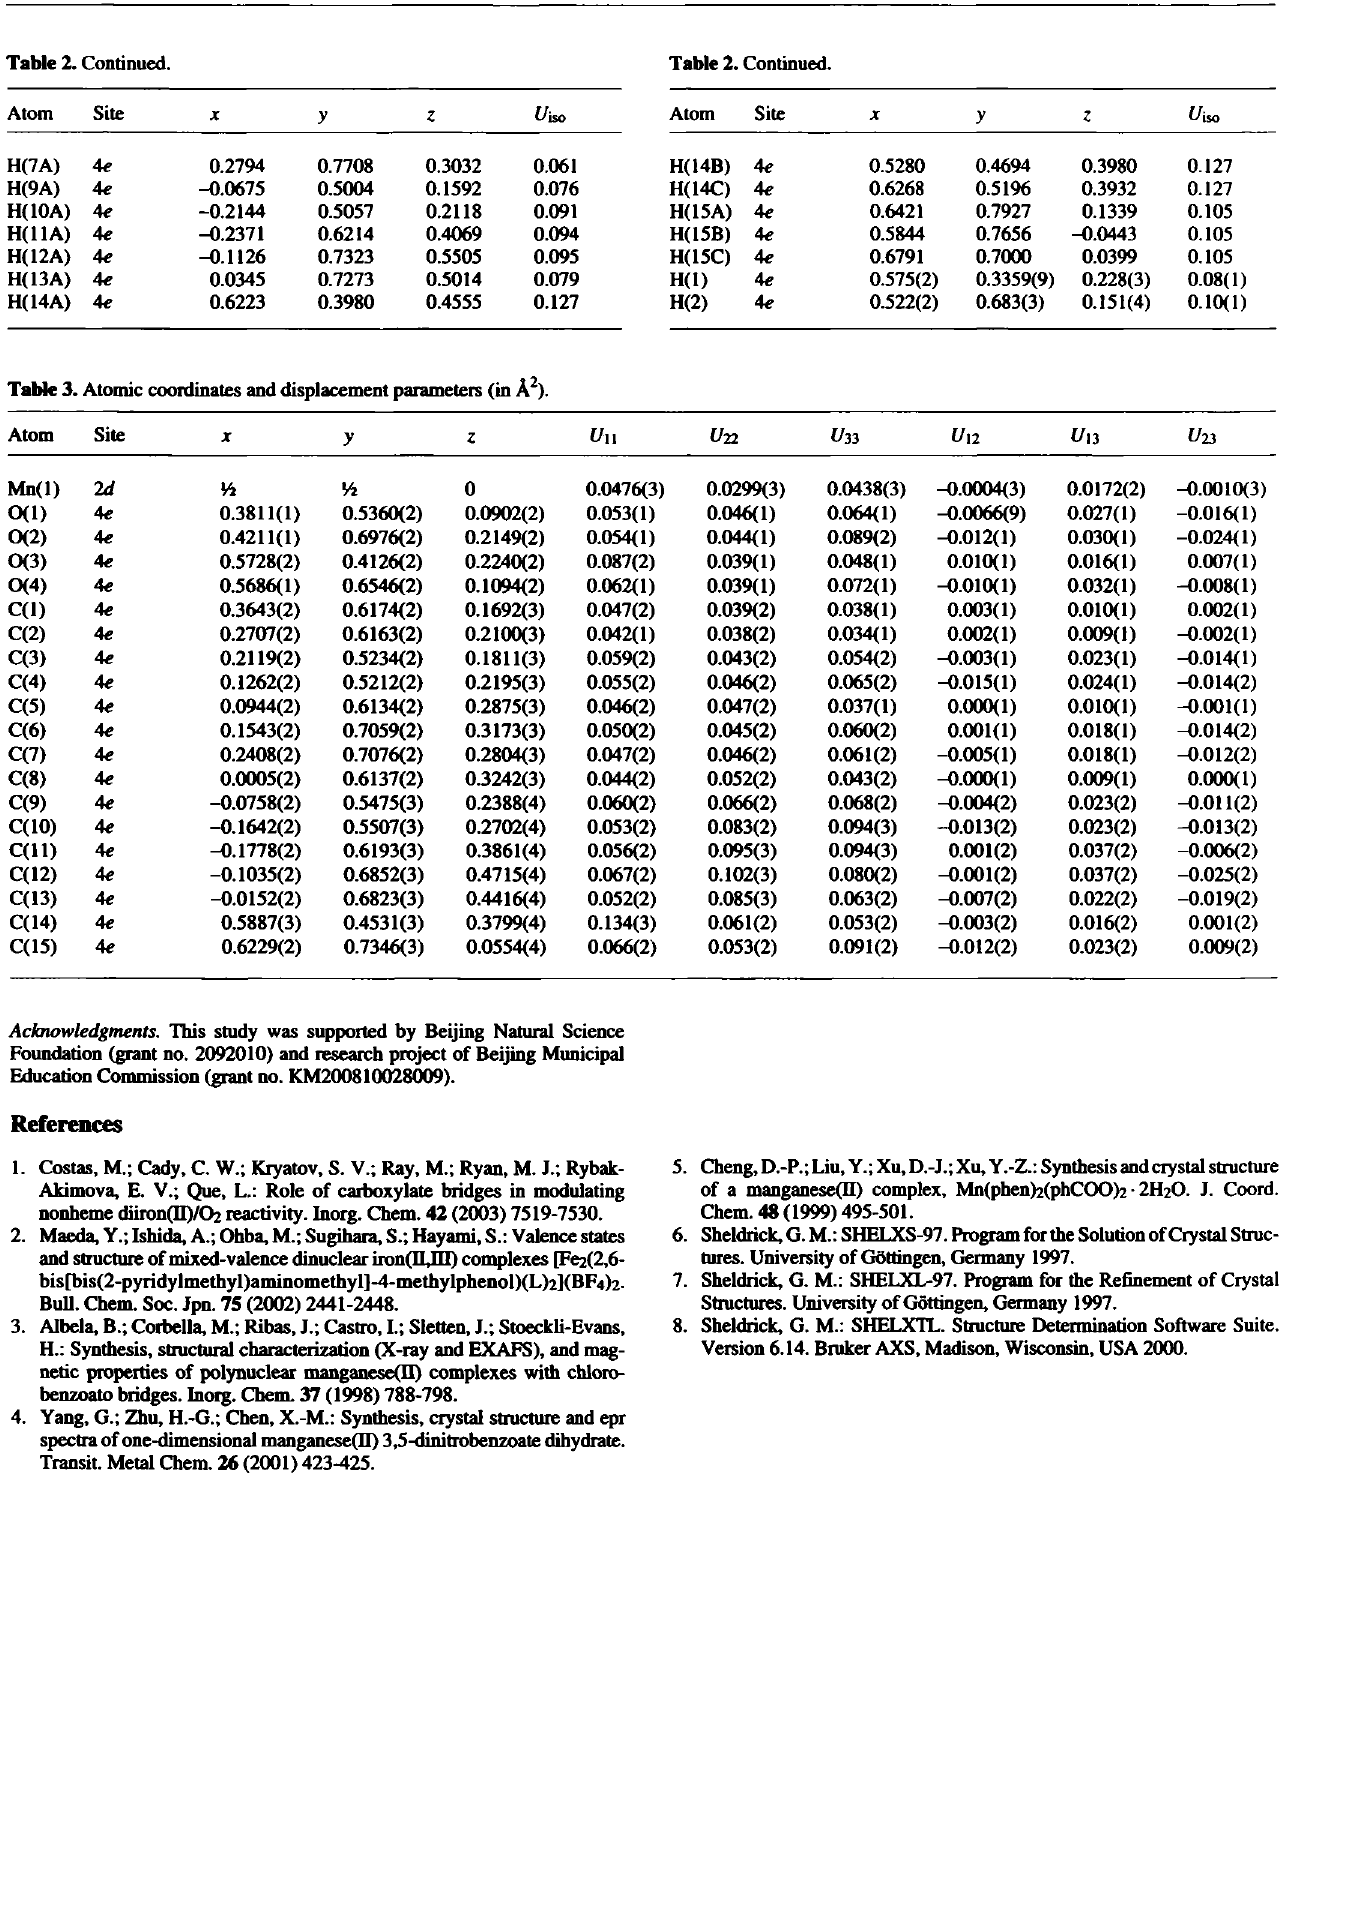
Table 3. Atomic coordinates and displacement parameters (in Â 2